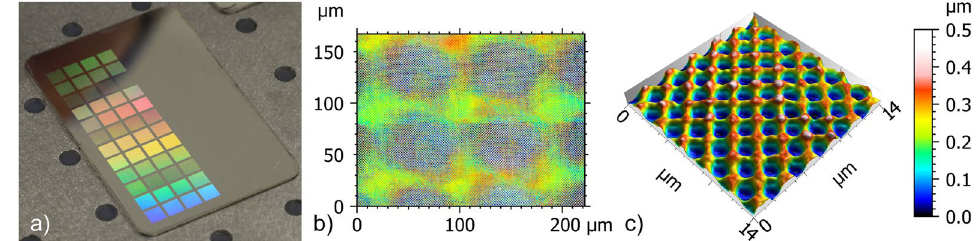
Figure 2. ( a) Photograph of the stainless steel surface treated with different number of pulses (from 1 to 5) and laser fluences (from 0.7 to 11.4 J/cm²); ( b ) confocal image of DLIP holographic pixels on the steel surface with a diameter of approximately 50 µ m; ( c ) typical hole-like pattern with a spatial period of 1.8 µ m and a structure depth of 0.3 µ m (the used laser fluence was 1.9 J/cm² and 3 pulses were